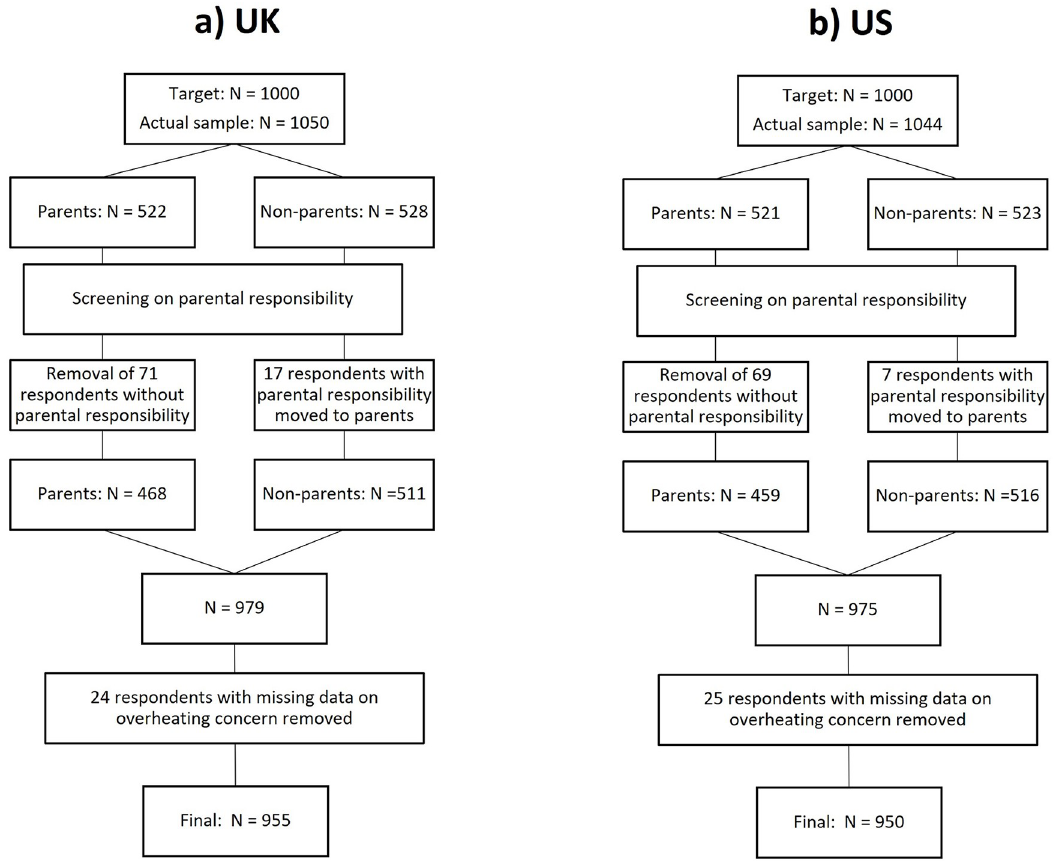
Fig 5. Diagram of data exclusion for the UK (a) and the US (b) to arrive at the final sample size.